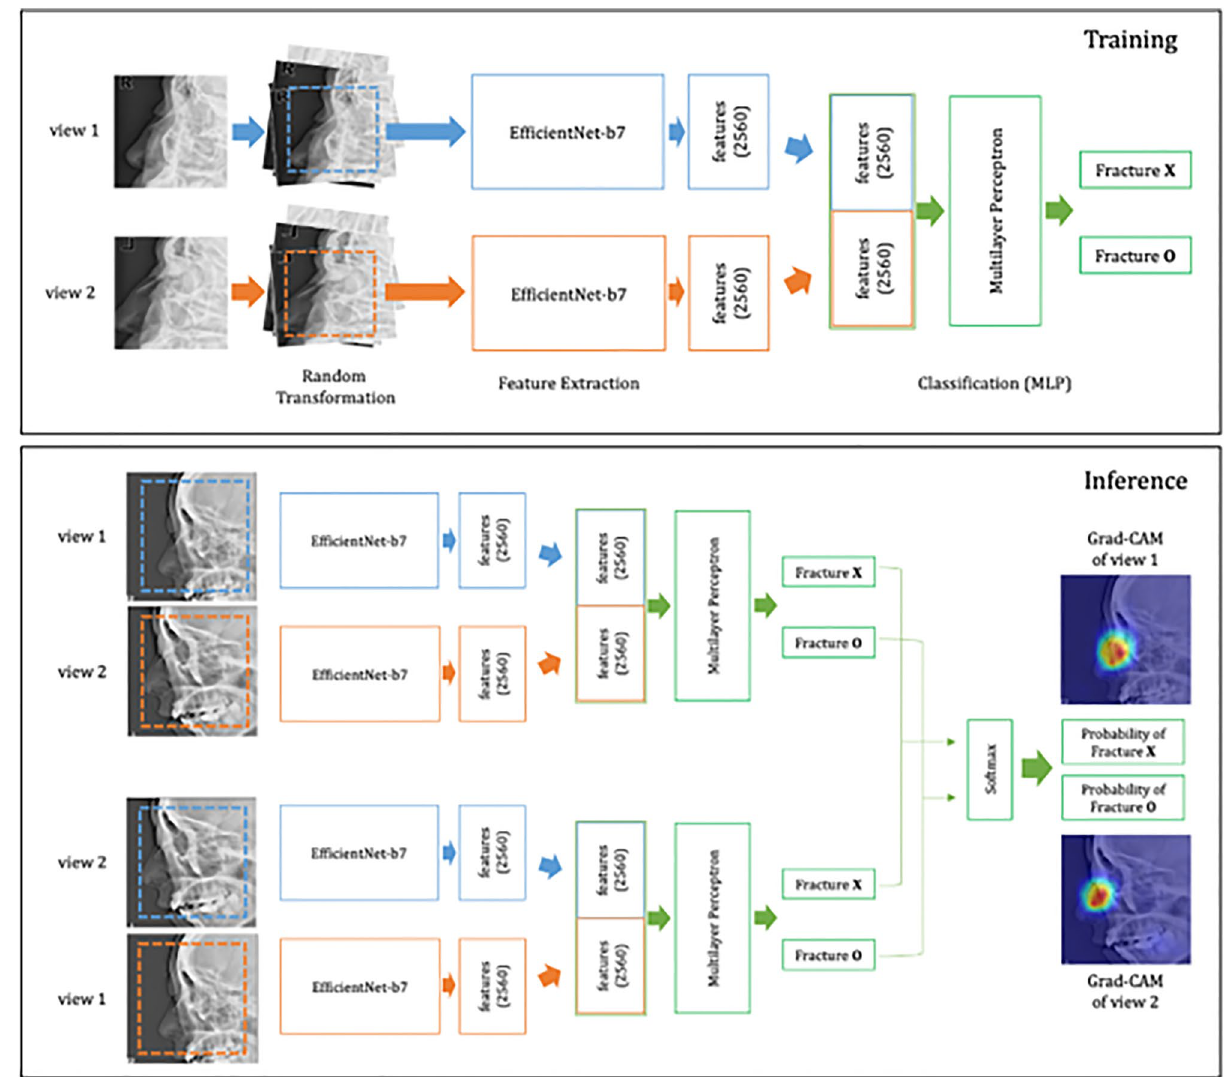
Figure 5. A workflow of training deep learning